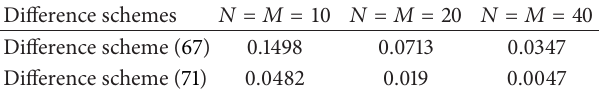
Table 3: Errors for the approximate solution of problem (94). Difference